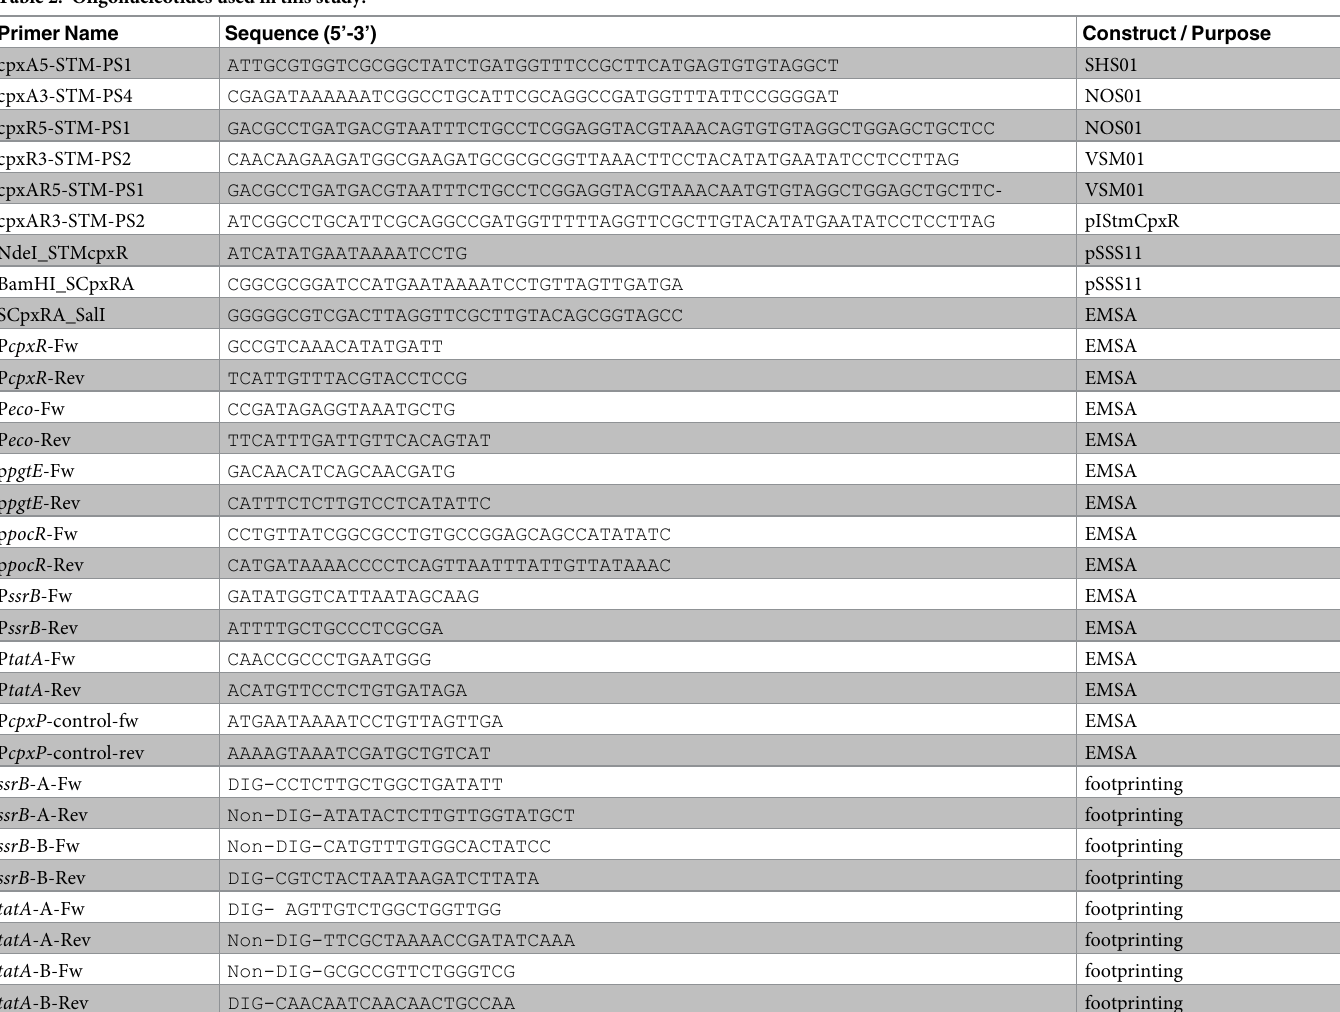
Table 2. Oligonucleotides used in this